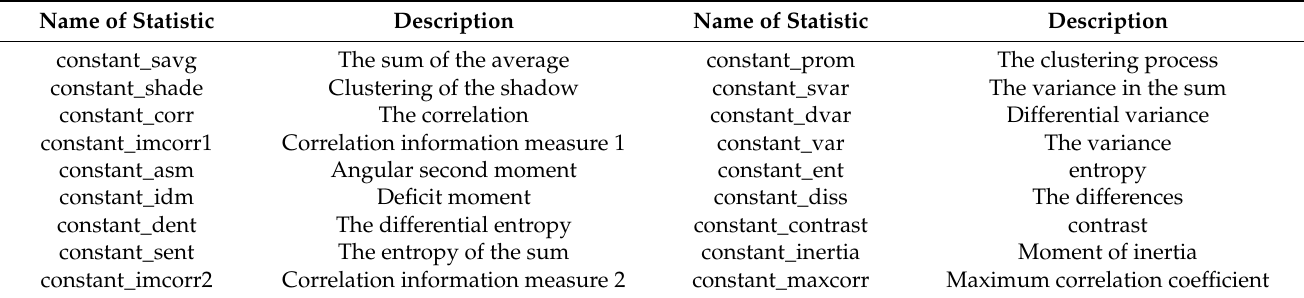
Table 5. GLCM texture statistics